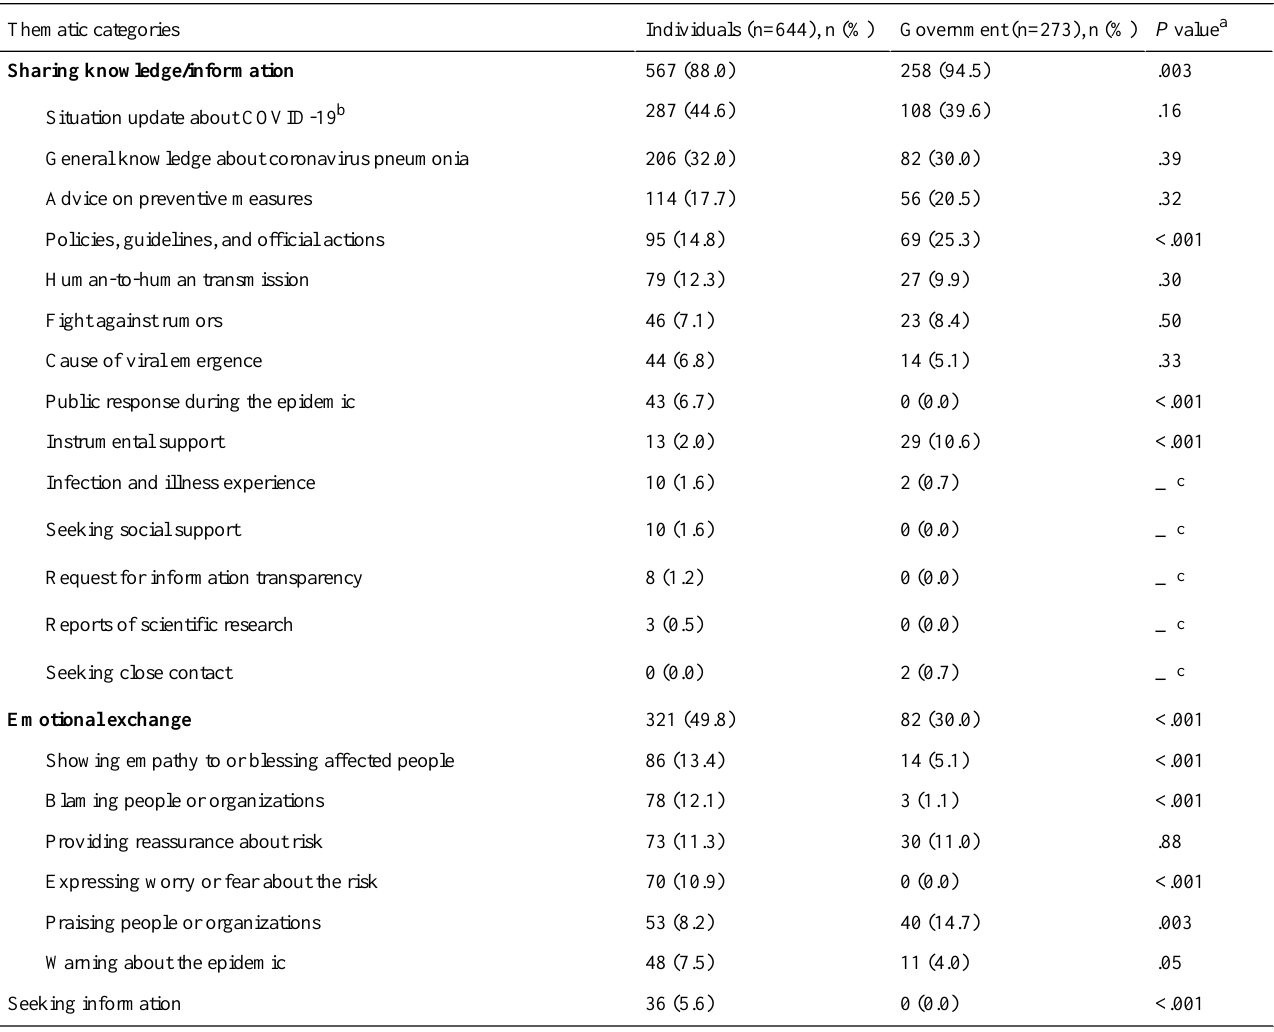
Table 2. Frequency of thematic categories from posts delivered by individual and government